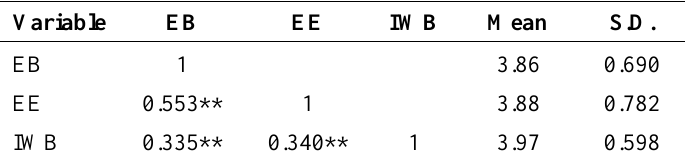
Table 1: Correlations and Descriptive Statistics Variable EB